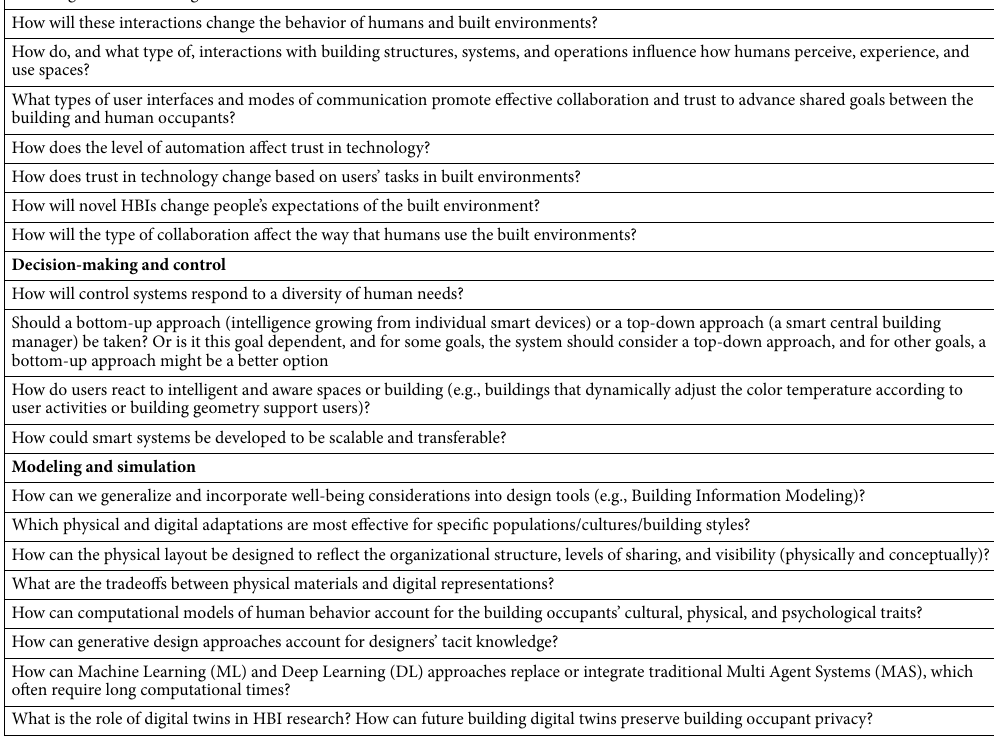
Table 2. Sample research questions related to interdisciplinary research areas of